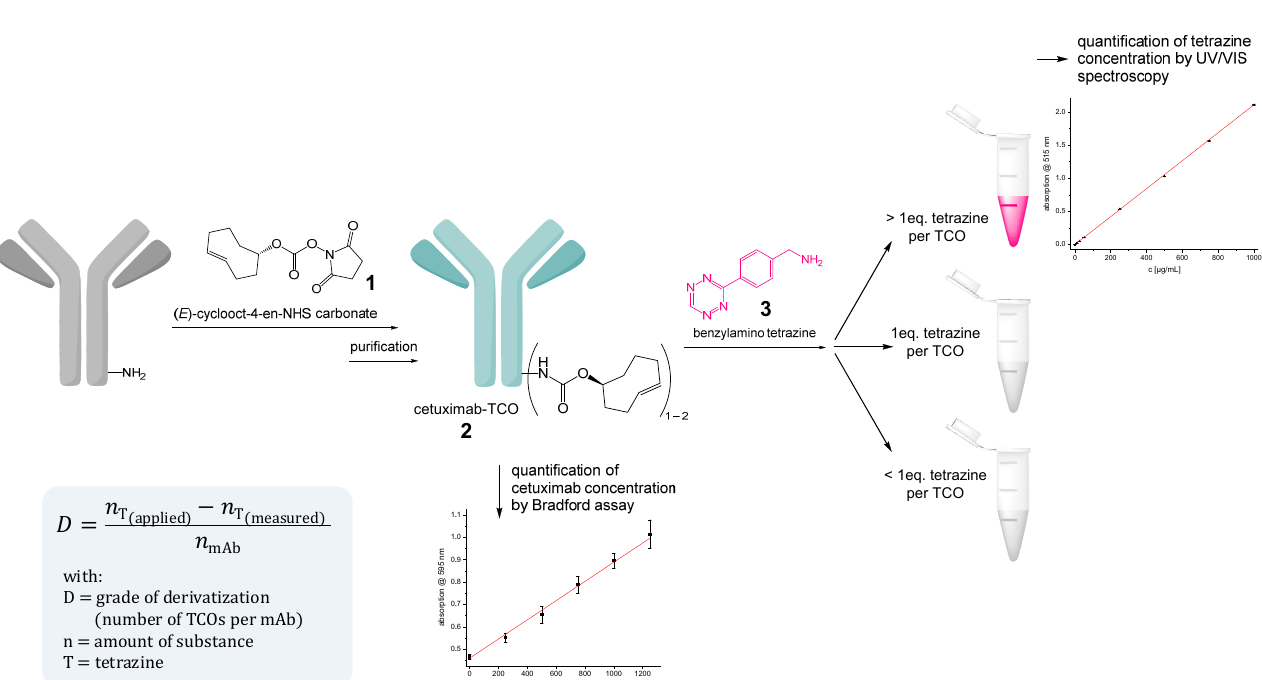
Figure 2. Schematic depiction of the antibody modification process with highly reactive TCO moieties, being followed by back-titration of TCO units and quantification using tetrazine and spectroscopic methods, giving the number of TCO modification sites per antibody molecule.